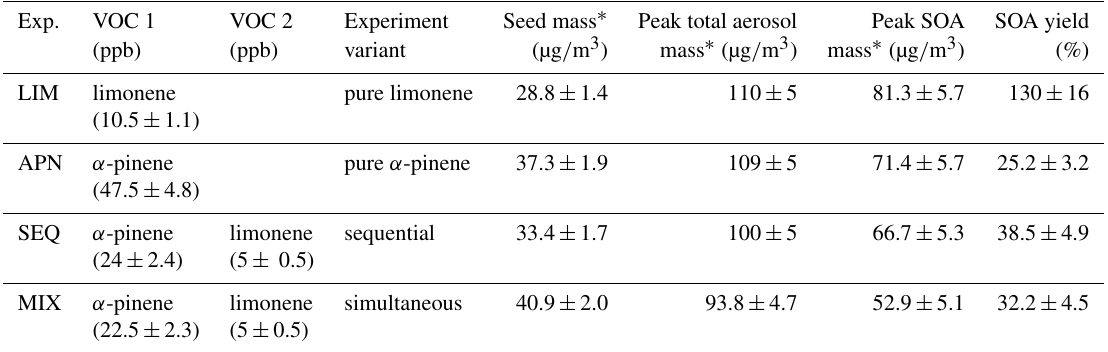
Table 2. Experimental conditions for environmental chamber experiments presented in this study alongside aerosol masses and SOA yields at 5 ◦